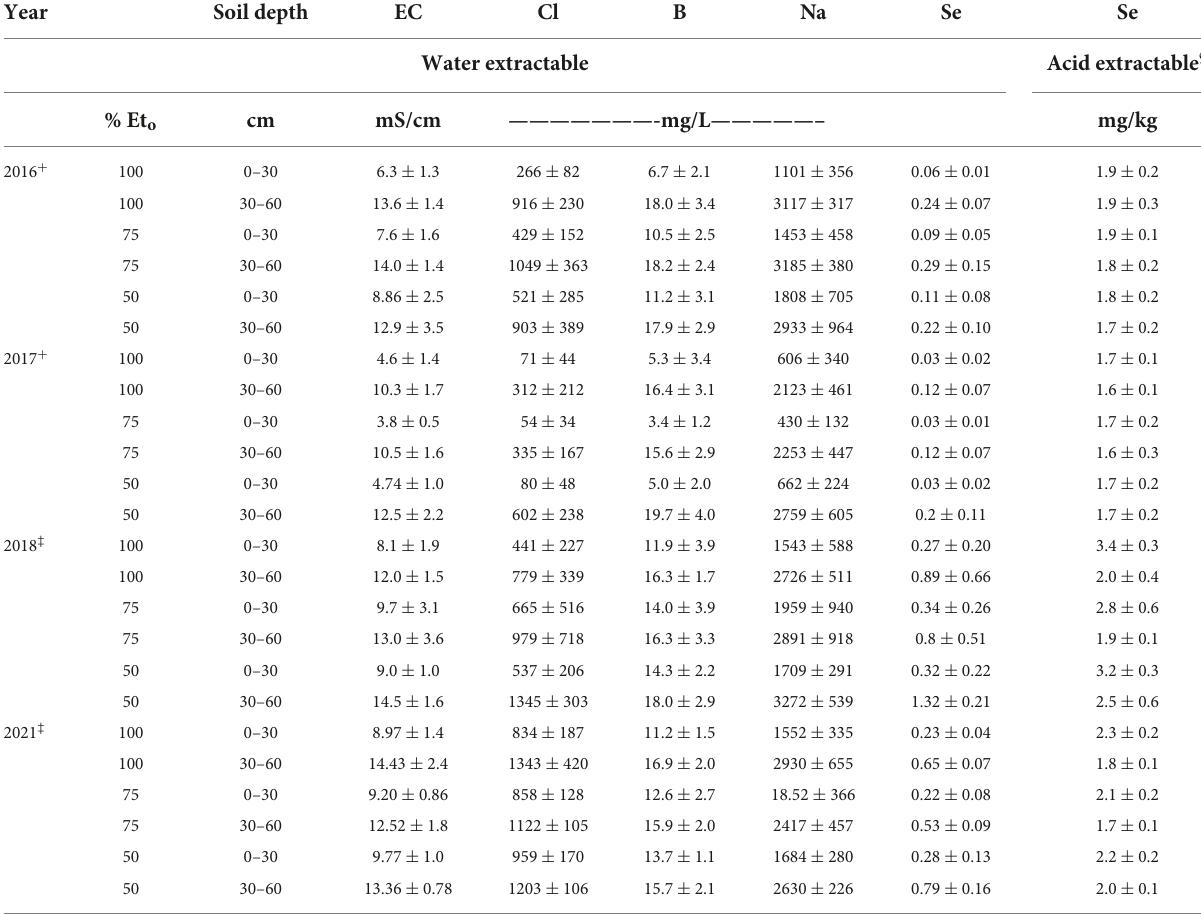
TABLE 4 Soil concentration of Cl, Na, B, and Se, and levels of EC at field site irrigated with different rates (irrigation treatment Et o ) in 4 years at post-harvest of agretti at two soil depths. Values represent average ( n = 5) ±